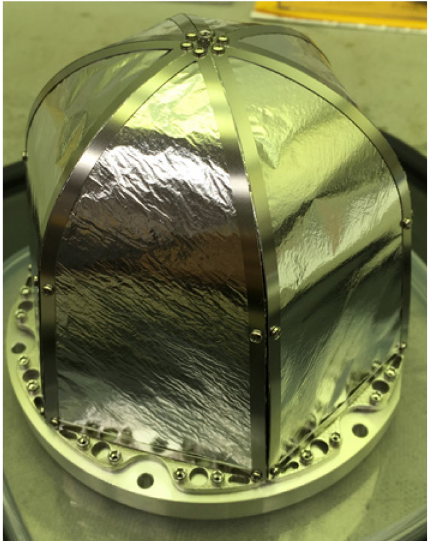
Fig. 4. Completely assembled